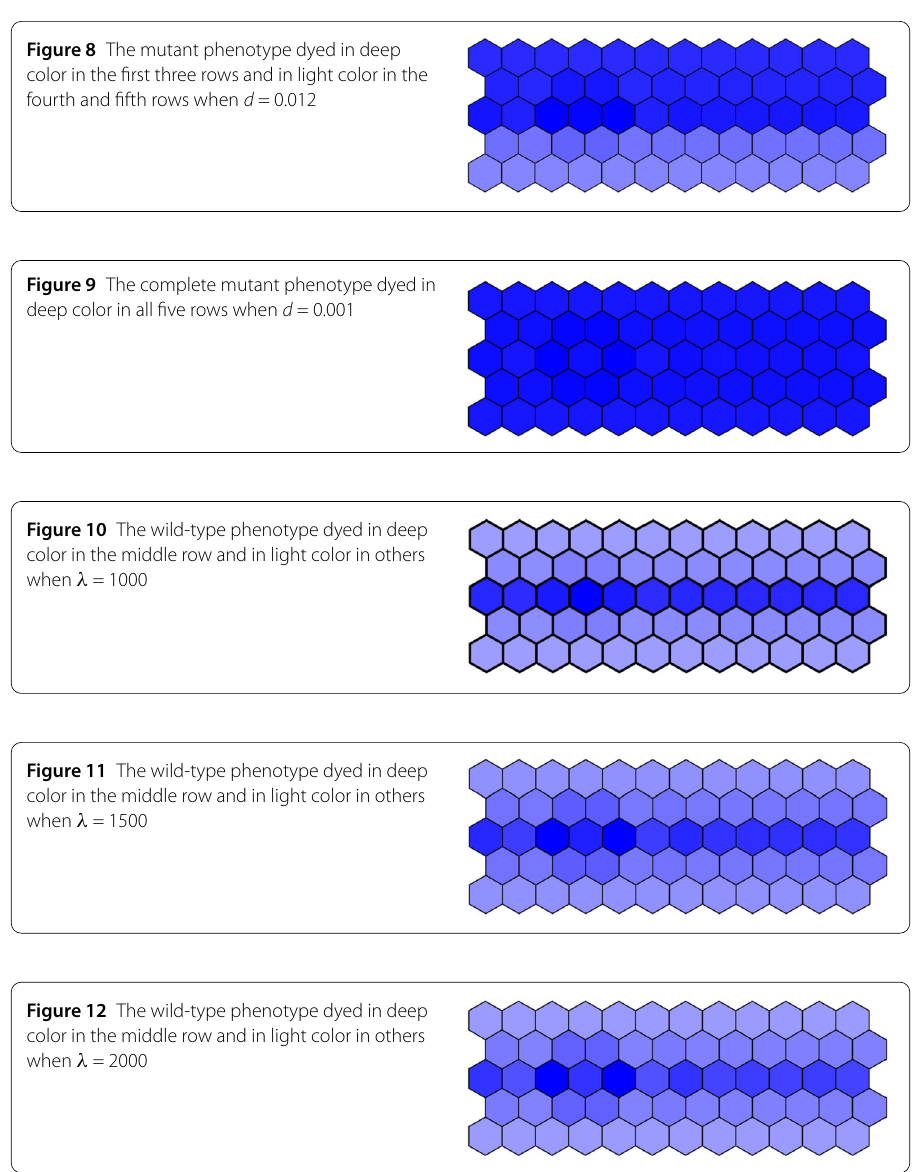
Figure 12 The wild-type phenotype dyed in deep color in the middle row and in light color in others when λ =